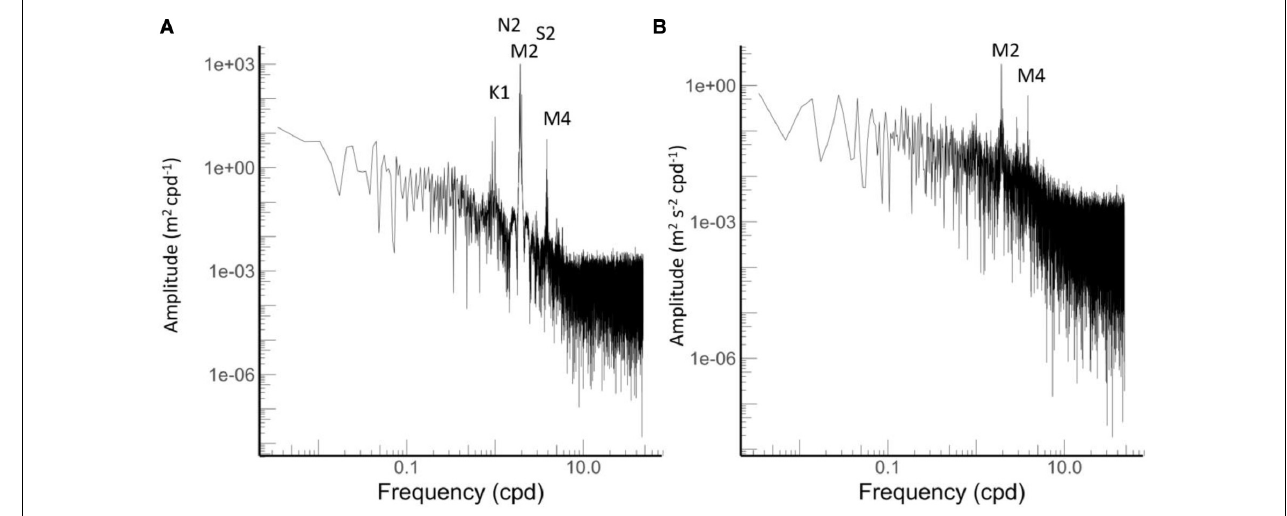
FIGURE 4 | Energy spectra from (A) pressure and (B) velocity data. Main tidal frequencies are indicated.